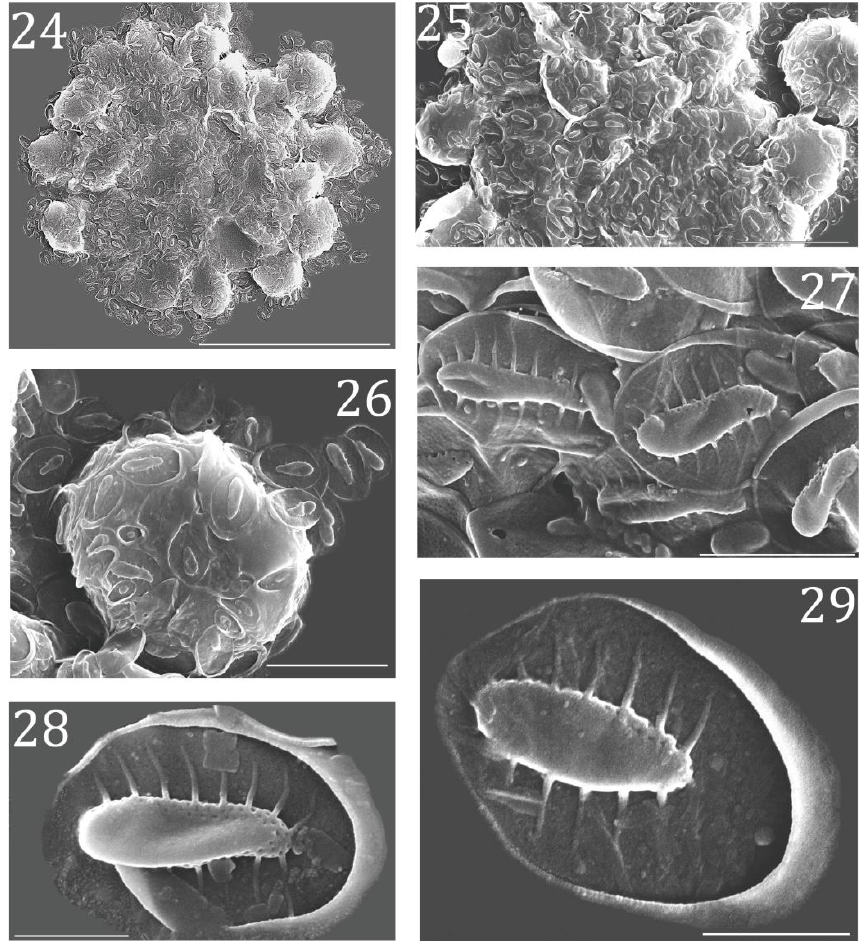
Figure 6. Morphological structures of Synura glabra collected from Shanxi, China. ( 24 – 25 ) Colony (SEM); ( 26 ) A single cell (SEM); ( 27 ) Body scales (SEM); ( 28 – 29 ) A single body scale with less- developed keels and several struts (SEM). Scale bars: ( 24 ) = 30 μm, ( 25 ) = 10 μm, ( 26 ) = 5 μm, ( 27 ) = 2 μm, ( 28 – 29 ) = 1 μm.